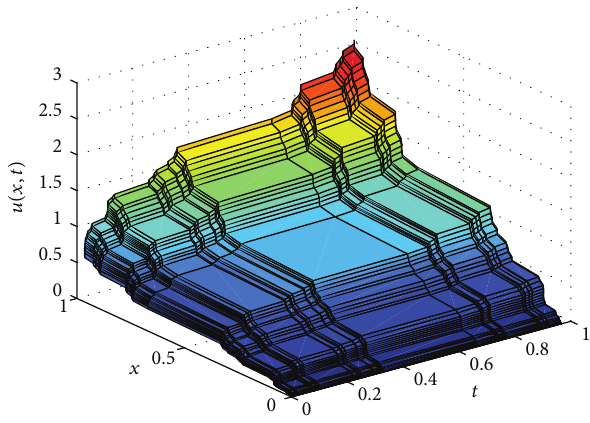
Figure 1: Exact solution for local fractional Laplace equation with fractal dimension 𝛼 = ln 2/ ln 3